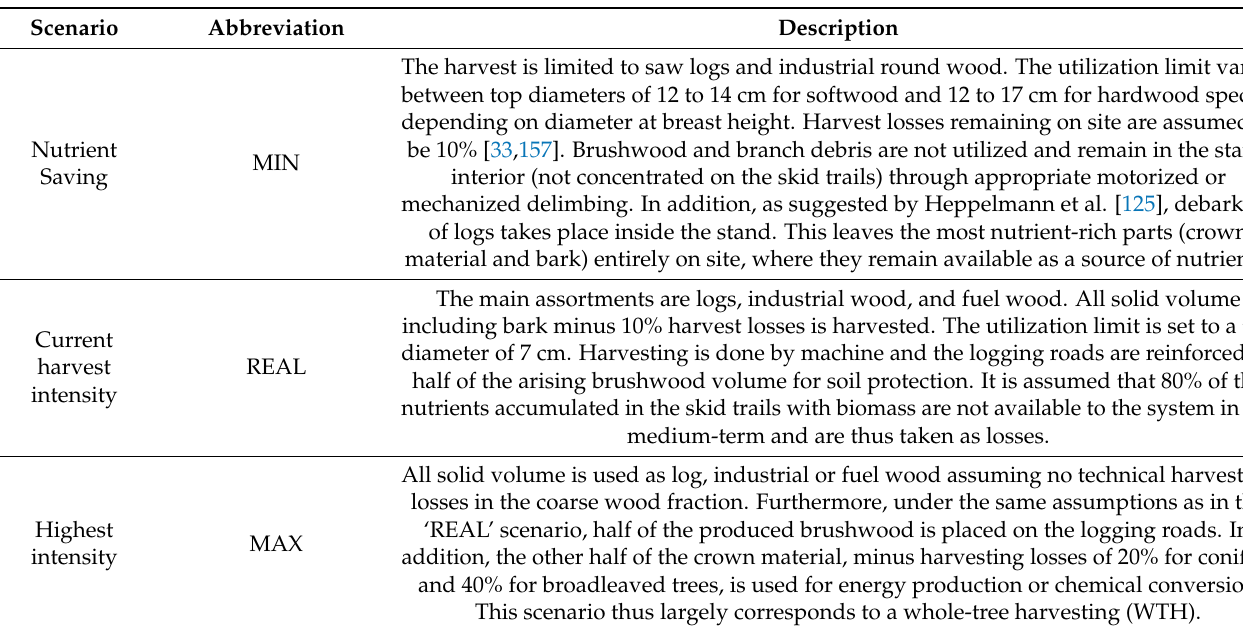
Table A1. Harvesting scenarios used for element balance